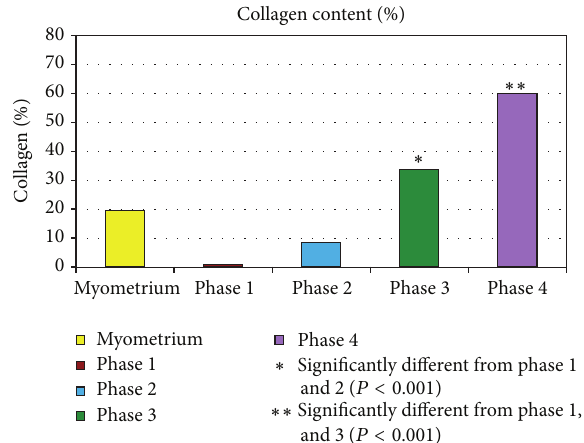
Figure 2: Mean percent collagen content of fibroid phases 1–4 by image analysis. The bar graph depicts the progressive accumulation of collagen in the transition from phase 1 to 4. There were 5 samples perphasegroupandthevaluesrepresentthemeans.Themyometrial bar is the mean value of 8 samples. ∗ Significantly different from phases 1 and 2 ( 𝑃 < 0.001 ). ∗∗ Significantly different from phases 1, 2 or 3 ( 𝑃 < 0.001